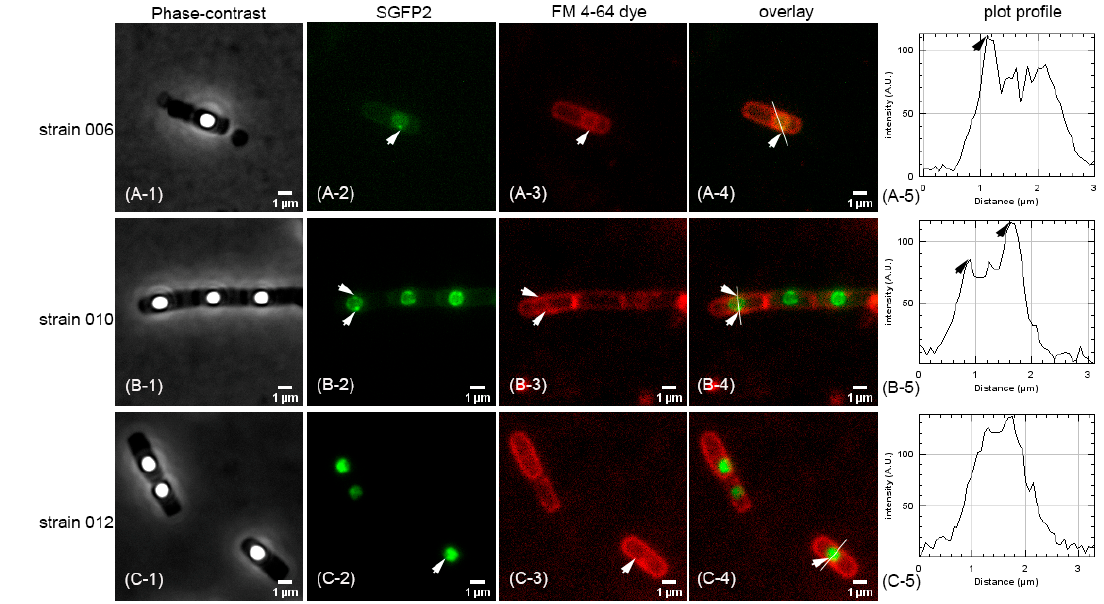
Figure 3. Wide-field microscopy imaging of B. cereus strains 006, 010, and 012 forespores stained with FM 4-64. Panels ( A-1 ), ( B-1 ), ( C-1 )—phase-contrast images. Panels ( A-2 ), ( B-2 ), ( C-2 )—foci of fusion proteins GerR(A-C-B)-SGFP2, GerD- SGFP2 (to allow visualization of this fusion in the presence of FM 4-64) and SASP-SGFP2 in developing forespores. Panels ( A-3 ), ( B-3 ), ( C-3 )—FM 4-64 staining of the IM of developing forespores. Panels ( A-4 ), ( B-4 ), ( C-4 )—merged foci in the channel between SGFP2 and FM 4-64 images. Panels ( A-5 ), ( B-5 ), ( C-5 )—plot profiles of the lines from merged images using ImageJ. The arrows in the various panels indicate positions of single foci in forespores. These samples were prepared and imaged as described in Methods.